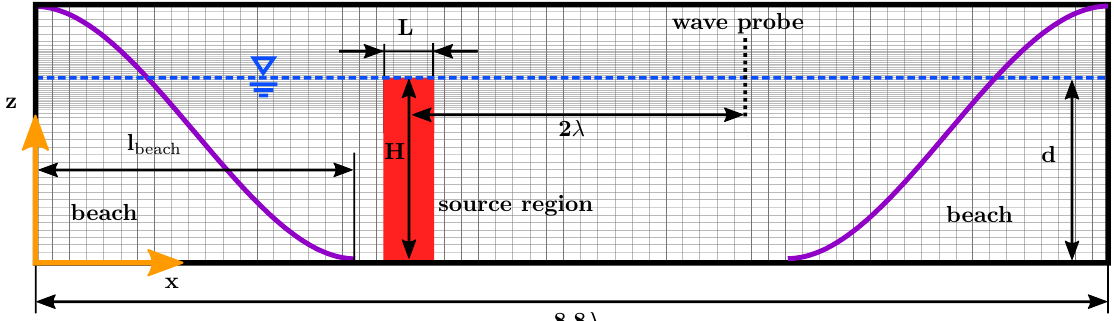
Figure 3. Schematic of the NWT including the main dimensions (schematic not at scale). The function of the gradual increase of sand in the numerical beach is included in purple. The source region is marked in red. The spatial discretisation, with a fine resolution around the free surface interface, is shown in the background. For the shallow water cases, the water depth d is set to 0.74 m for the intermediate water case to 0.025 m and for the deep water case to 0.74